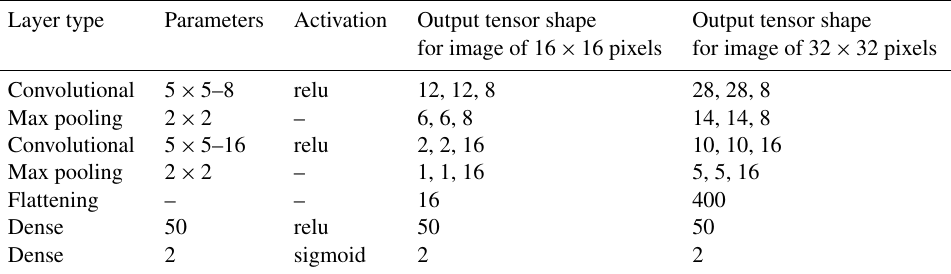
Table 4. The layers of the CNN by Liu et al. (2016) for comparison with ours. This table follows the same syntax as Table 3. The number of trainable parameters are 5776 for images of 16 × 16 pixels and 24976 for images of 32 × 32